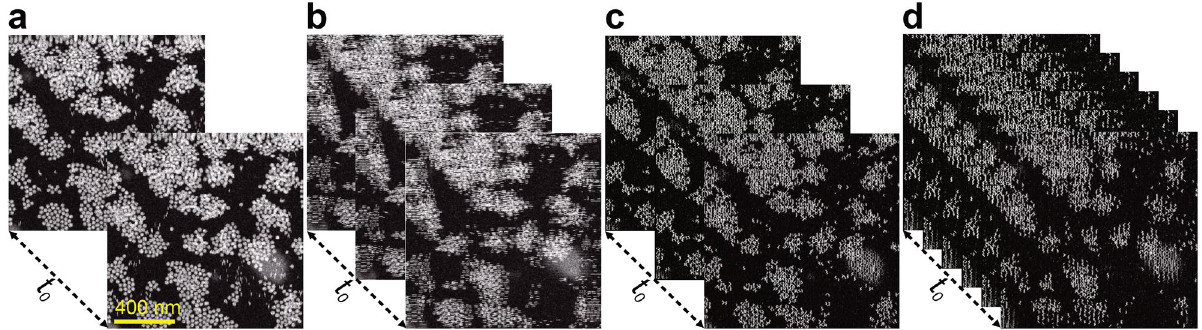
Figure 7. Schematic of sequential image acquisition for in-situ AuNPs in liquid phase TEM. Individual frames acquired from the beam assembly process of colloidal AuNPs in a liquid layer of 700 nm thickness. ( a ) At the same time t 0 = 23 ms it takes to acquire two sequential 256 × 256 raster scan images (τ = 400 μs and T D = 2 μs); the framerate can be improved 1.8, 1.6 and 5.4 times by implementing: ( b ) serpentine, ( c ) sparse 1/3 (τ = 400 μs) and ( d ) sparse(1/3)-serpentine scanning pathways respectively. Further analysis requires the rectification and reconstruction procedures implemented earlier.